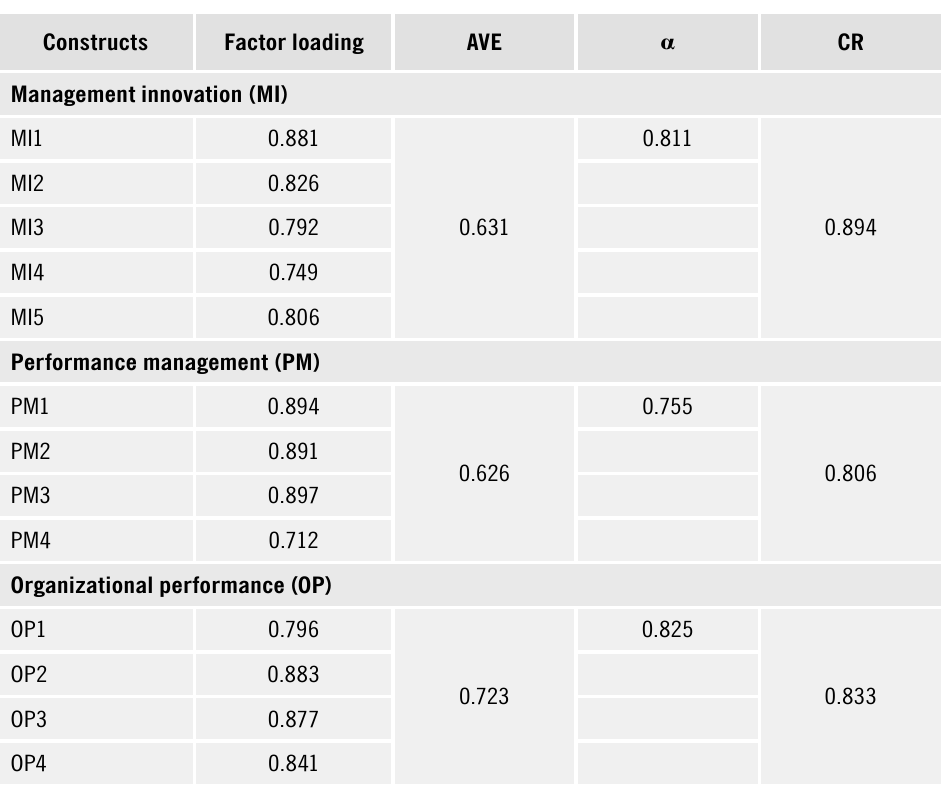
Table 4. Reliability and